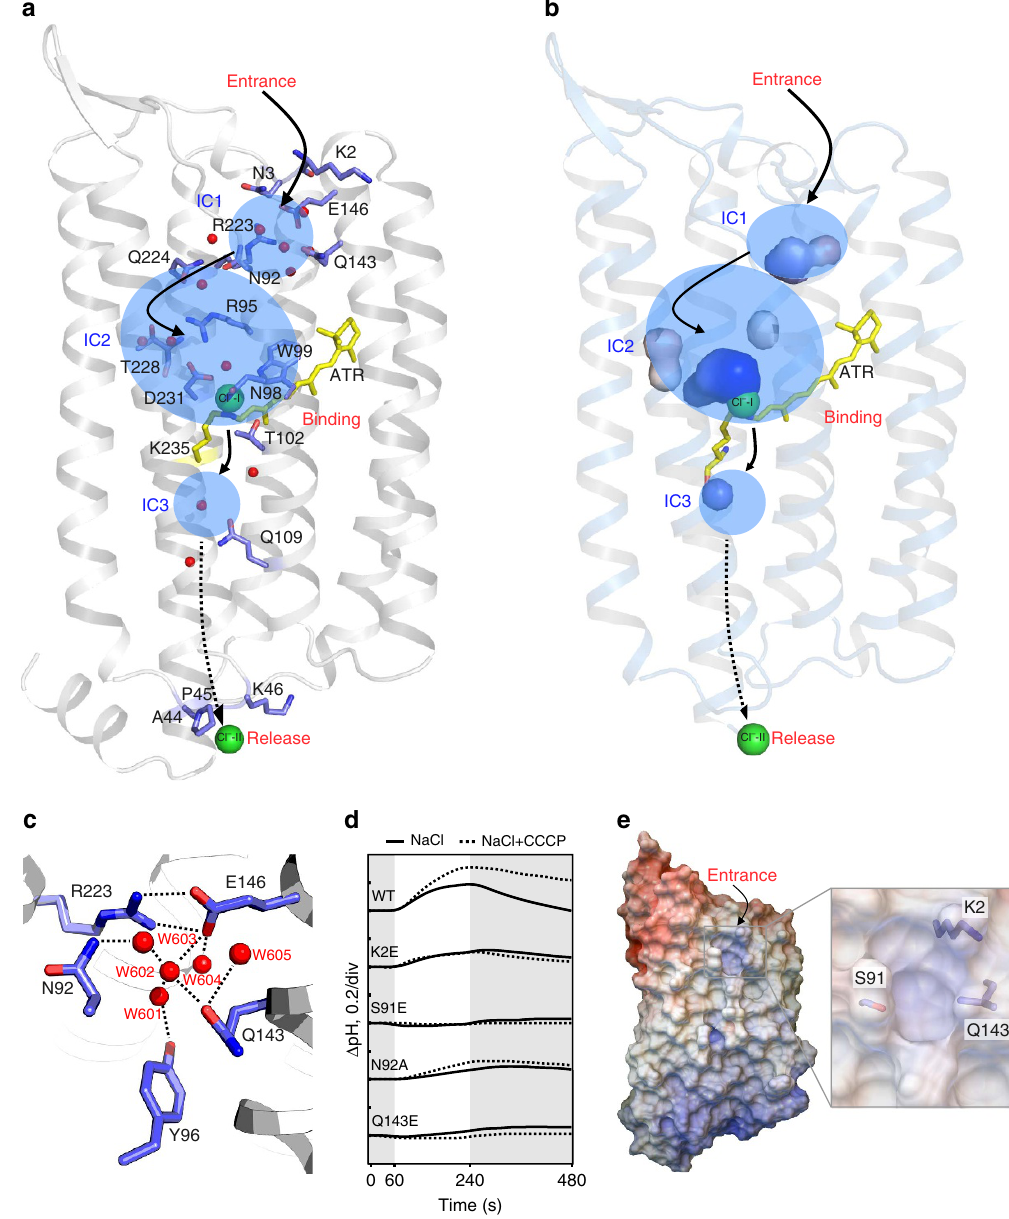
Figure 5 | Chloride ion conductance pathway in ClR. ( a ) Three internal cavities (IC1–IC3) inside the ClR structure are highlighted in transparent blue. Water molecules inside the ClR structure are shown in red spheres and amino-acid residues, which interact with the water molecules are indicated. Proposed chloride ion conductance pathway in ClR is shown in arrows (beyond water molecules, dashed arrow). The chloride ions bound to ClR and ATR are shown in green spheres and a yellow stick model. ClR is in the same orientation as Fig. 1a. ( b ) Cavity surface view of ICs in a . ( c ) Magnified view of IC1. ( d ) Light-induced pump activities of wild-type (WT) ClR and its mutants at Lys2, Ser91, Asn92 and Gln143. The pumping activities are measured in NaCl (lines) and NaCl with carbonyl cyanide m -chlorophenylhydrazone (CCCP; dashed lines). Grey and white sections indicate dark and light conditions, respectively. ( e ) Surface electrostatic potential of ClR. A putative chloride ion entry hole is The water molecules form a hydrogen bond network with mutants K2E, S91E and Q143E to introduce a bulky, negatively Thr228, Arg95 and Asp231. Chloride ions are likely to reach the charged side chain into the amino acids around the hole. The Cl (cid:2) -I-binding site through IC2. IC3 is formed around Gln109 of pumping activity of ClR expressed in E. coli was almost shut the ‘NTQ motif’ on the cytosolic side of the retinal (Fig. 5a,b and down in the mutants S91E and Q143E and significantly affected Supplementary Fig. 6d). Two water molecules in IC3 interact with by the K2E mutation (Fig. 5d), suggesting that the bulky neighbouring amino-acid residues Ala50, Ser54, Gln109, Lys235 negatively charged side chain affects the activity of ClR by and Thr242. Another water molecule, which interacts with physically and electrostatically inhibiting the entry of chloride Trp201 and Ser234, is observed between the retinal and IC3. ions into the hole. Beyond IC3 in ClR, there are no more water molecules on the Four water molecules (W502–W505) and one chloride ion cytosolic side indicating that the cytosolic side of ClR is closed. (Cl (cid:2) -I) are observed in IC2 (Fig. 5a and Supplementary Fig. 6c).